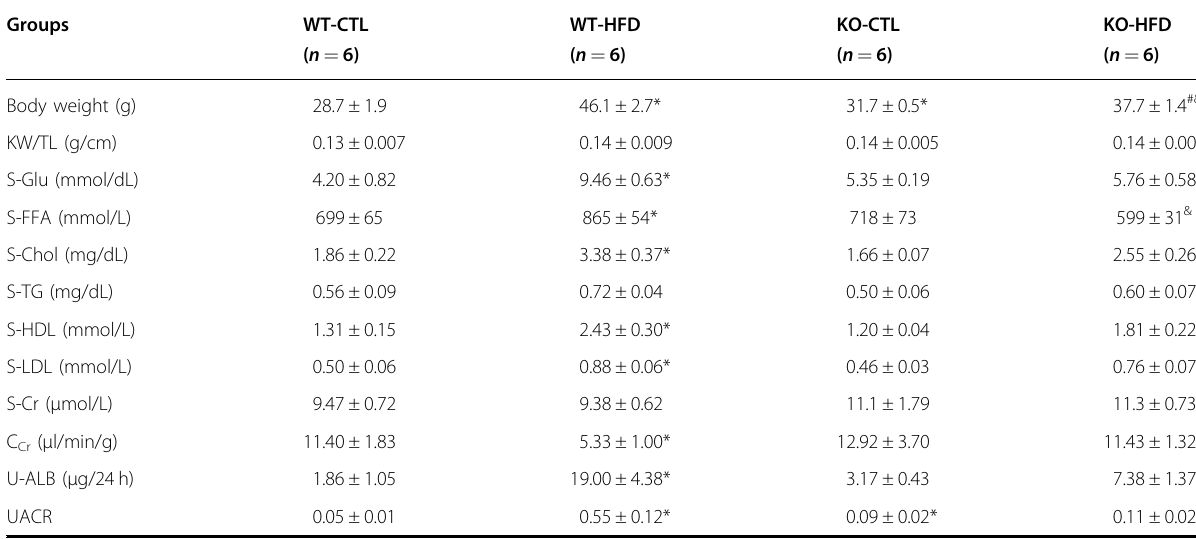
Table 1 Functional data of Mas + / + and Mas − / − mice with or without HFD.